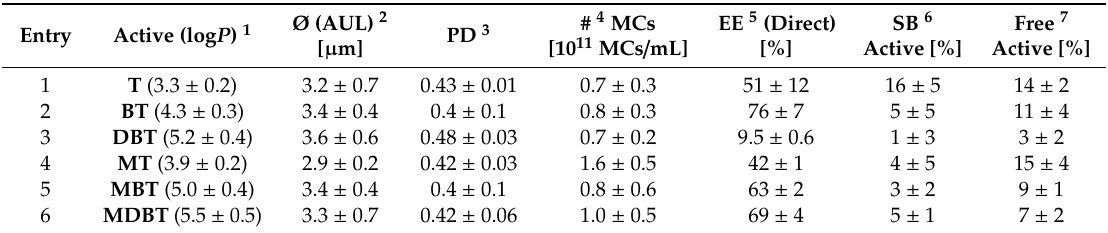
Figure 2. Micrographs of realised SLS-MCs containing thymol and derivatives. Table 1. Morphological key data for realised systems of SLS-MCs containing thymol and derivatives. Data represent the mean values of three different batches.